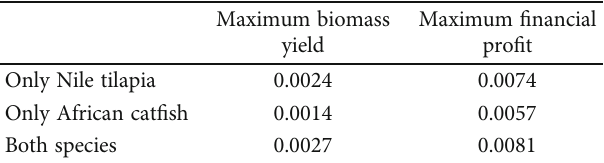
Table 6: Simulation results using optimal harvest rates found in MATLAB, using patternSearch. The columns present the maximum sustainable biomass yield (grams per litre and day) and maximum sustainable fi nancial pro fi t (USD per litre and day). The rows indicate the fi sh stock